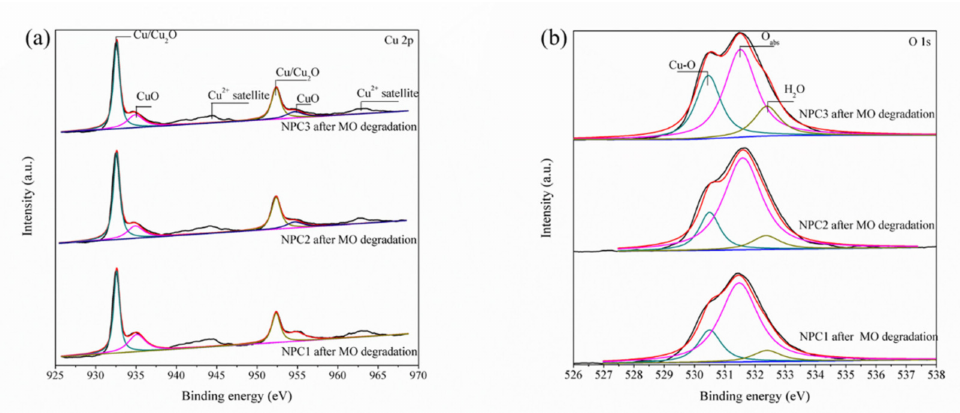
Figure 5. XPS high-resolution spectra of the Cu 2p ( a ) and O 1s ( b ) regions of three nanoporous copper catalysts after MO degradation.